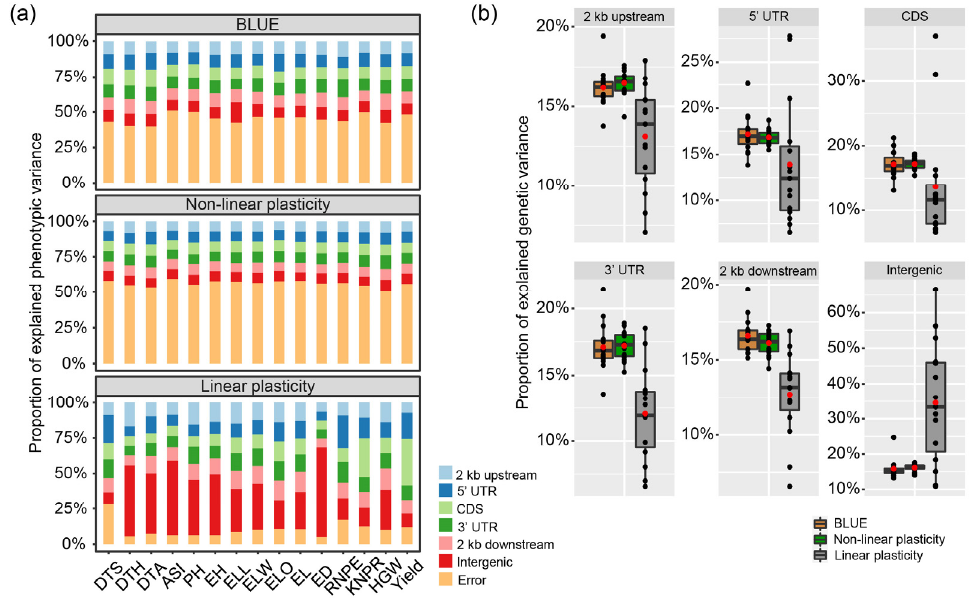
Figure 4. Contribution of different gene regions to genotypic performance and plasticity. Proportion of ( a ) phenotypic and ( b ) genetic variance explained by SNPs in six categories: 2 kb upstream, 5 ′ UTR, CDS, 3 ′ UTR, 2 kb downstream and intergenic, shown for the BLUE across seven environments, the non-linear plasticity, and the linear plasticity. DTS, days to silking; DTH, days to heading; DTA, days to anthesis; ASI, anthesis-silking interval; PH, plant height; EH, ear height; ELL, ear leaf length; ELW, ear leaf width; ELO, ear leaf order; EL, ear length; ED, ear diameter; RNPE, row number per ear; KNPR, kernel number per row; HGW, hundred-grain weight; Yield, yield per hectare. The black point indicate each value of trait. The red points indicate mean values.